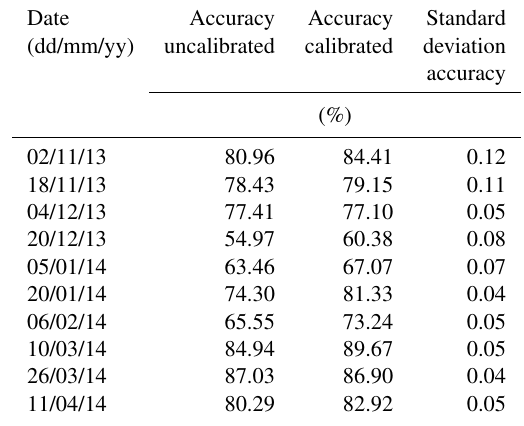
Table 7. Classification accuracy of modeled snow extent based on pixel comparison with Landsat 8 snow maps. Calibrated accuracies are averaged over all members and the standard deviation represents the standard deviation in individual member accuracies (after cali-